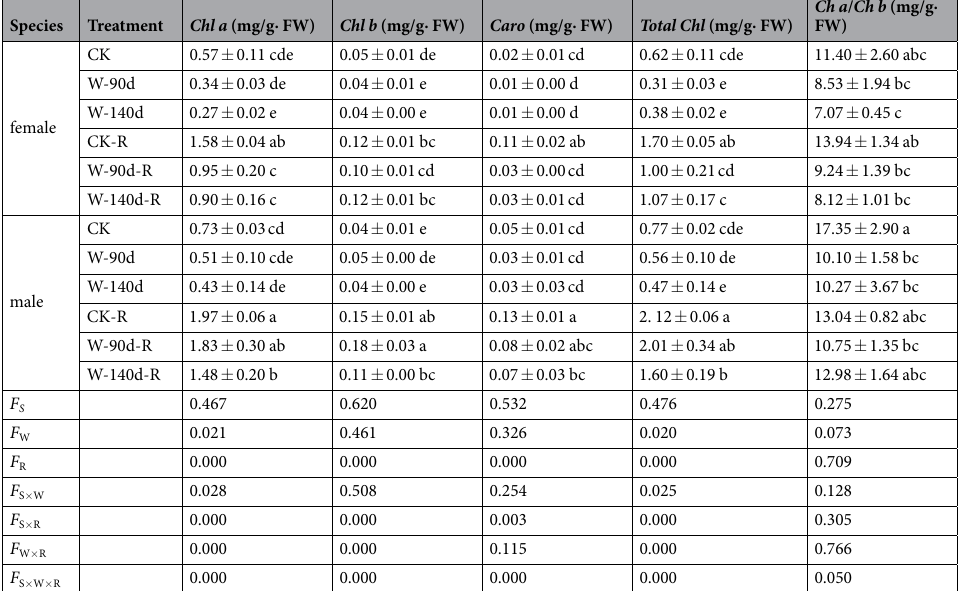
Table 2. Pigment content variation in male and female P. deltoides under winter flooding stress and post- flooding recovery. CK, control treatment; W, flooding and waterlogging stress treatment; R, recovery after waterlogging stress. Values are means ± SE ( n = 5). Letters above the columns indicate significantly differences at P < 0.05 according to Duncan’s test. The significance values of the factorial analysis (ANOVA) for: F S , F W , and F R refer different effects of species, watering, and recovery growth, respectively; F S × W , F S × R , F W × R , and F S × W × R refer species × watering effects, species × recovery growth effects, watering × recovery growth effects, and species × watering × recovery growth effects,